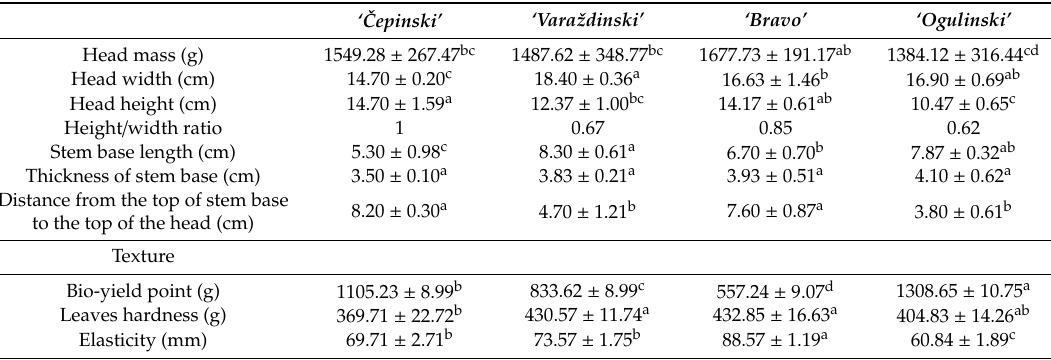
Table 1. Physical and morphological properties of cabbage